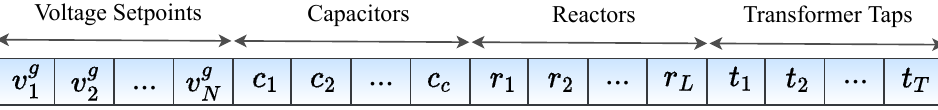
Figure 5. Illustration of a candidate solution to the ORPD